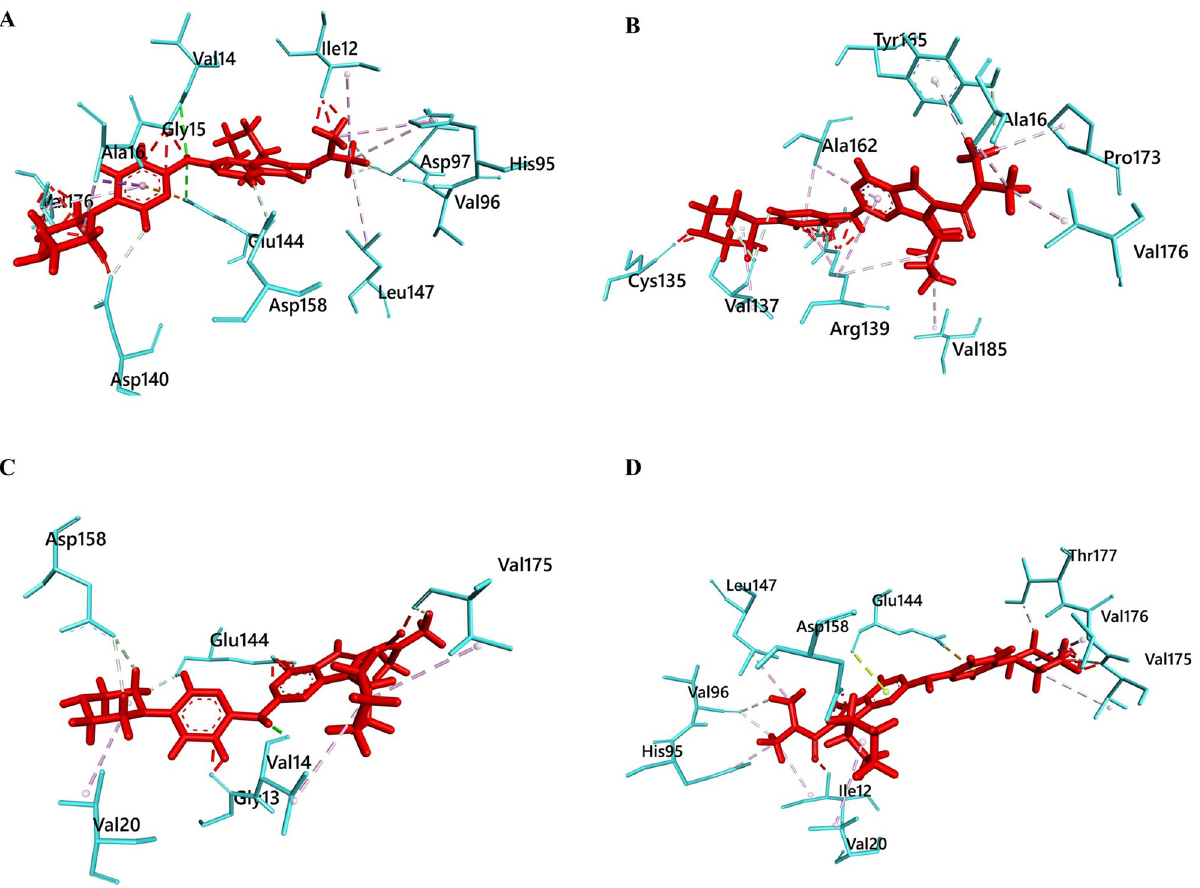
Fig 5. Protein-ligand residual interaction analysis of (A) Native CDK4 (Aqua) with ribociclib (red) (B) G15S mutant (aqua) with ribociclib (red) (C) D140Y mutant (aqua) with ribociclib (red) and (D) D140H mutant (aqua) with ribociclib (red). The interacting bonds are displayed as: Conventional hydrogen bonds/ Carbon hydrogen bonds as green line, pi-pi stack/pi-alkyl as pink lines, Salt bridge/ attractive charge/ electrostatic as brown